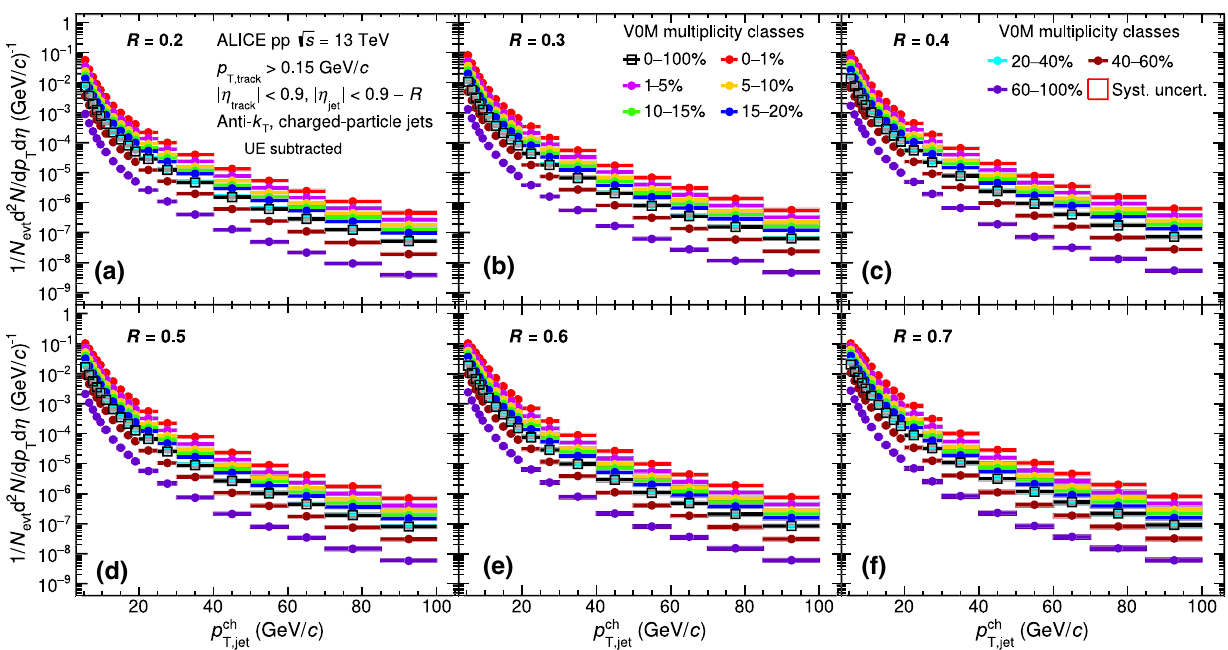
Fig. 7 Charged-particle jet yields in different V0M multiplicity percentile intervals for resolution parameters R varied from 0 . 2 to 0 . 7 in pp √ s = 13 TeV. Statistical and total systematic uncertainties are shown as vertical error bars and boxes around the data points, collisions at